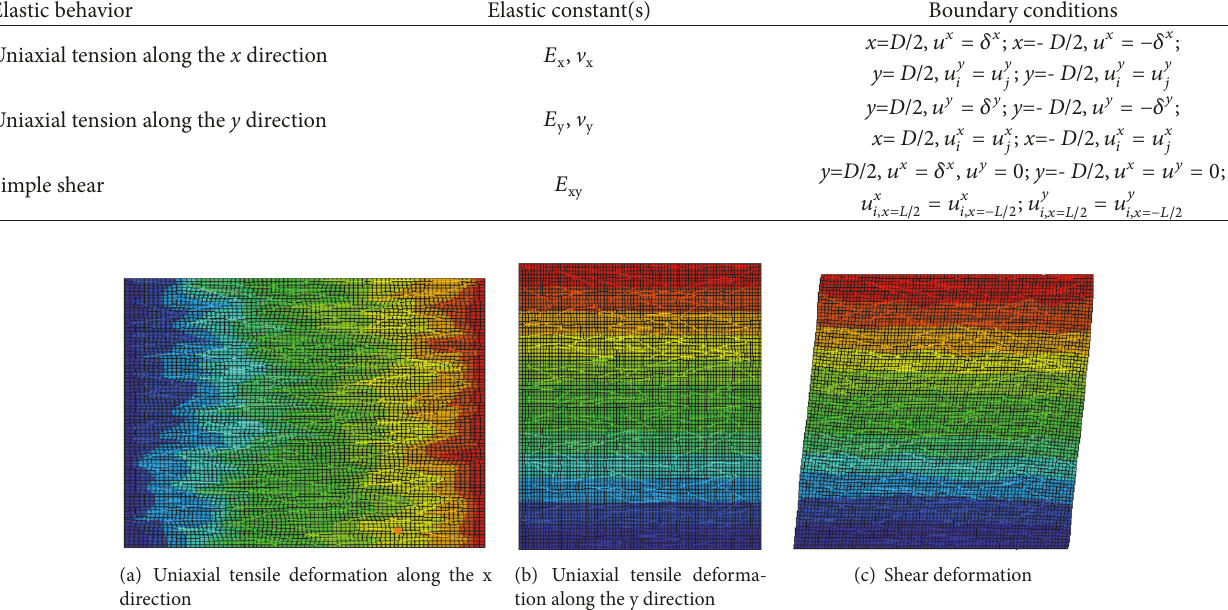
Figure 5: Different elastic deformations of short-fiber-reinforced